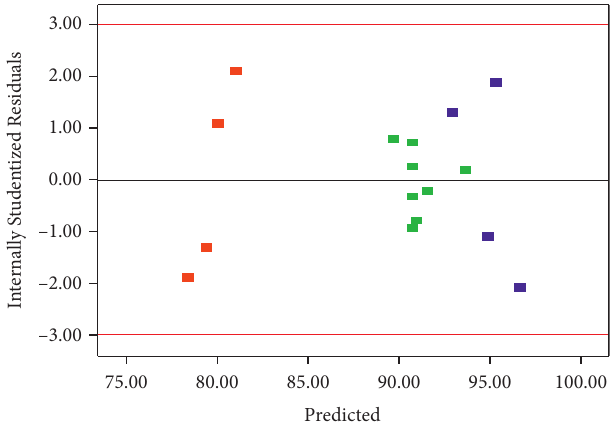
Figure 9: Residuals vs.